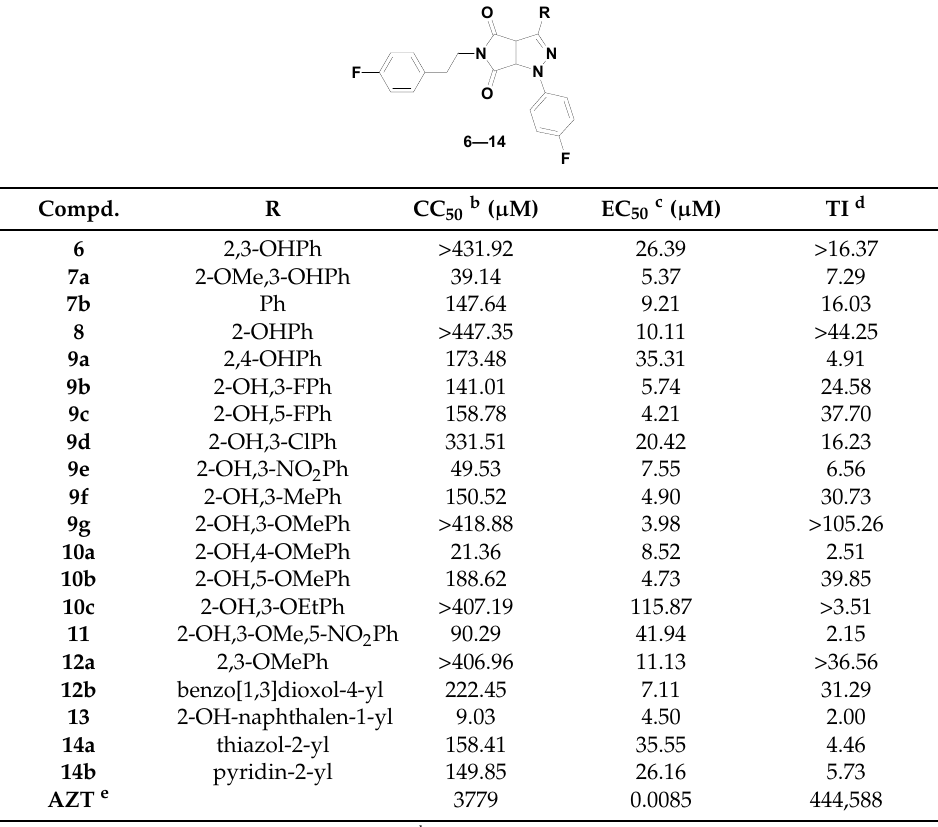
Table 1. Anti-HIV-1 activity of compounds 6 – 14 in vitro a .